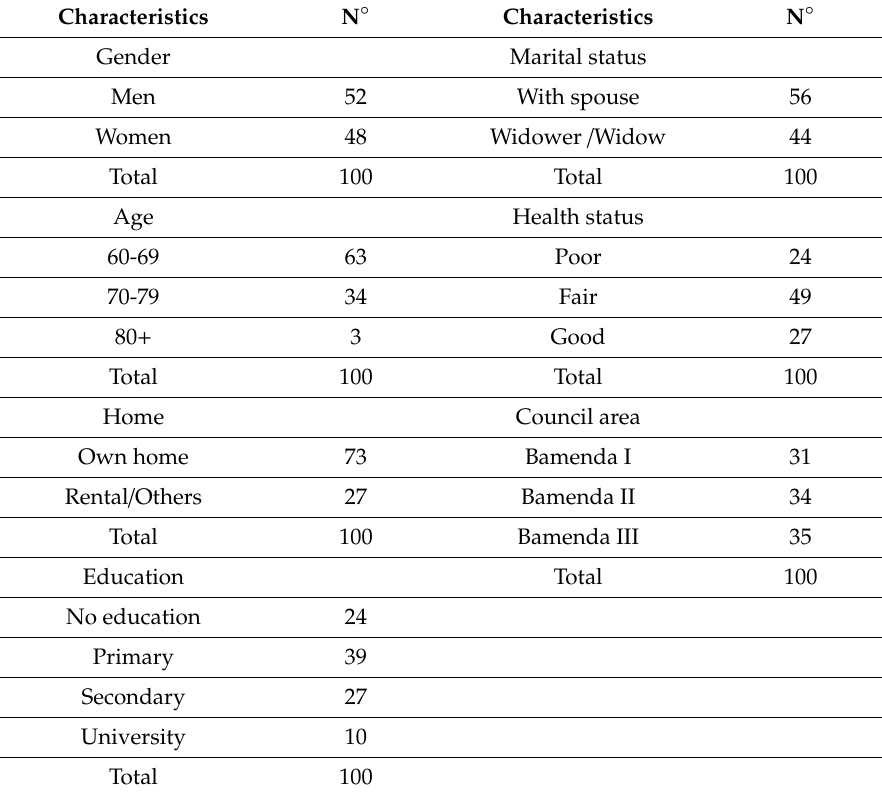
Table 3. Characteristics of focus group